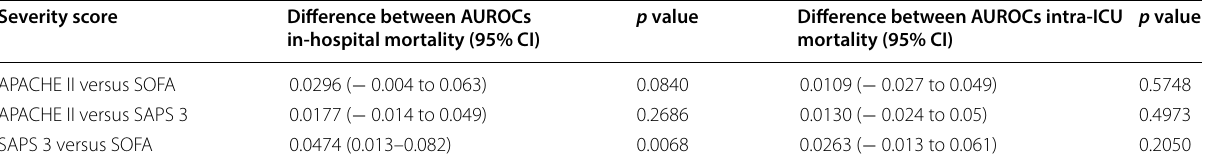
Table 4 Pairwise comparison of prediction scores AUROC curves